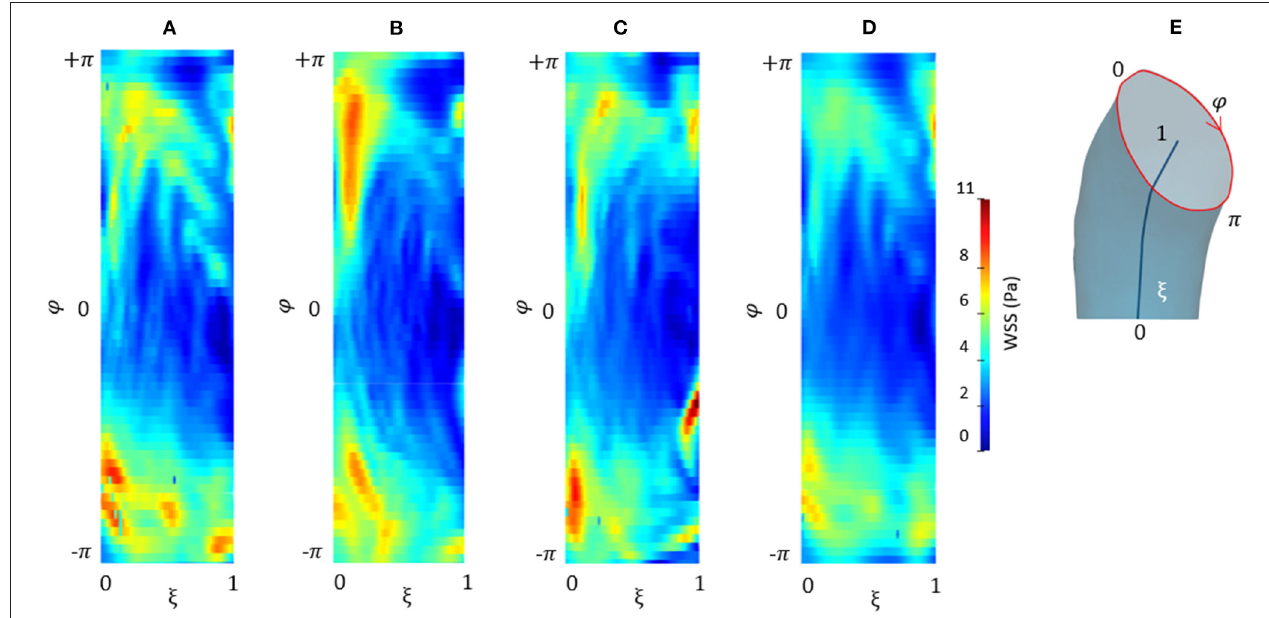
FIGURE 10 | Contour map of the unfolded WSS for CFD at p 0 (A) , CFD at p 4 (B) , CFD RBF (C) , and FSI (D) simulations. Circumferential and longitudinal coordinates are represented in (E)